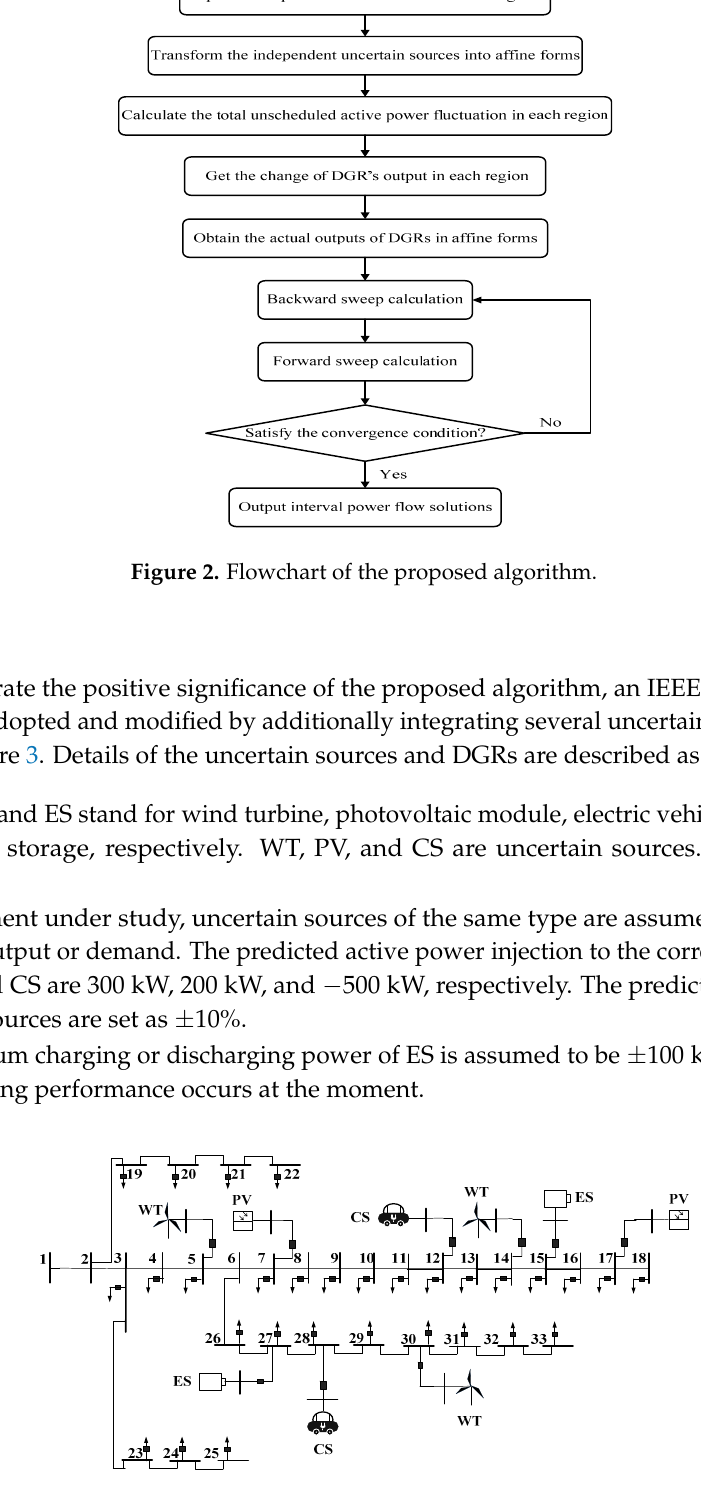
Figure 3. Modified IEEE 33-bus distribution system.